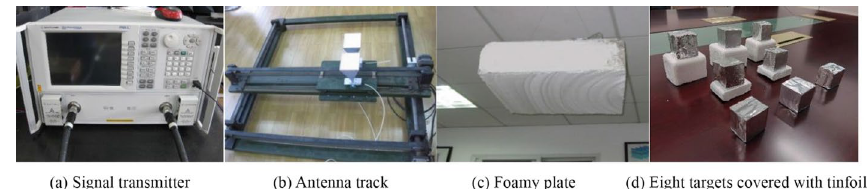
Fig. 10 3D sparse array SAR system